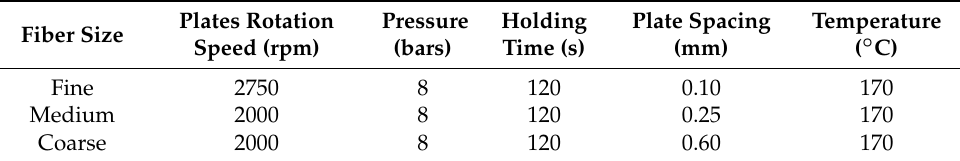
Table 1. Refining parameters for white spruce chips.